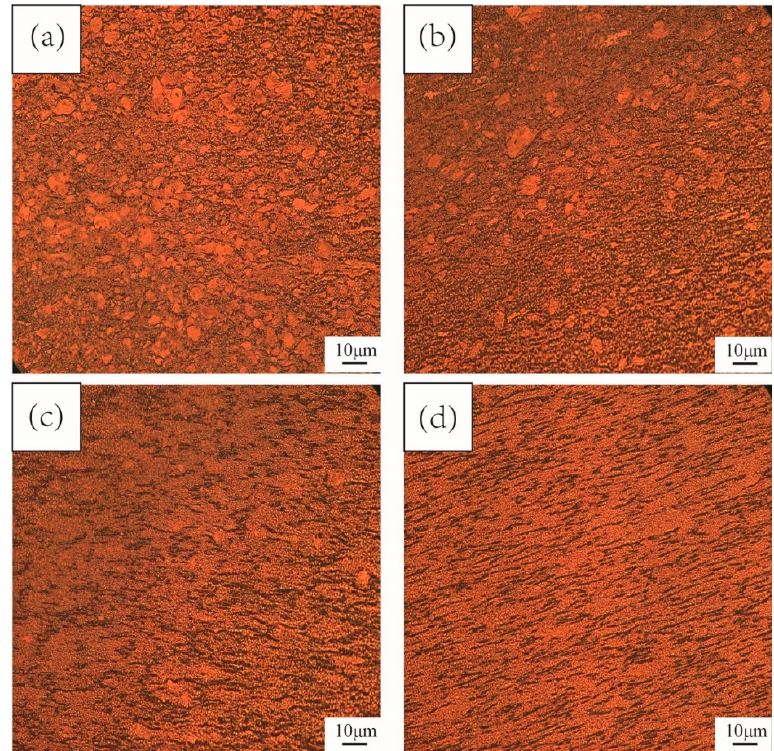
Figure 9. Microstructure of TC4 alloy after MDIF: ( a ) one cycle; ( b ) two cycles; ( c ) three cycles; ( d ) four cycles.